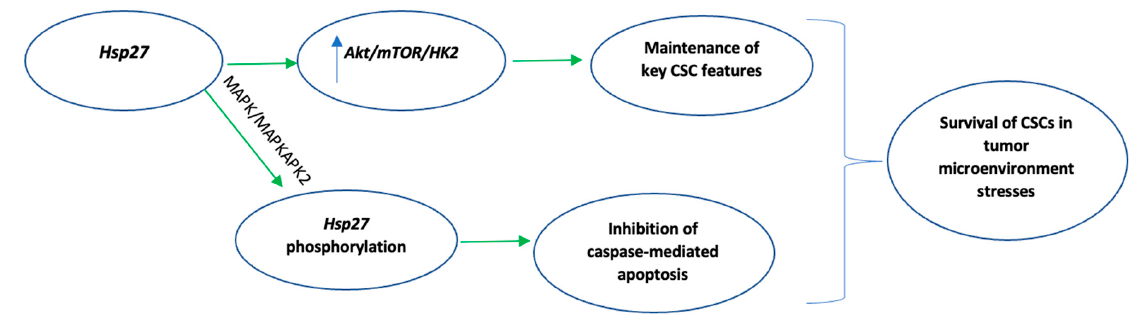
Figure 3. Summary of Hsp27-mediated molecular mechanisms which enable cancer stem cells to survive tumor microenvironment stresses. Green indicates activation. Key: CSC, cancer stem cells; PI3, phosphatidylinositol-3-kinase; mTOR, mammalian target of rapamycin.